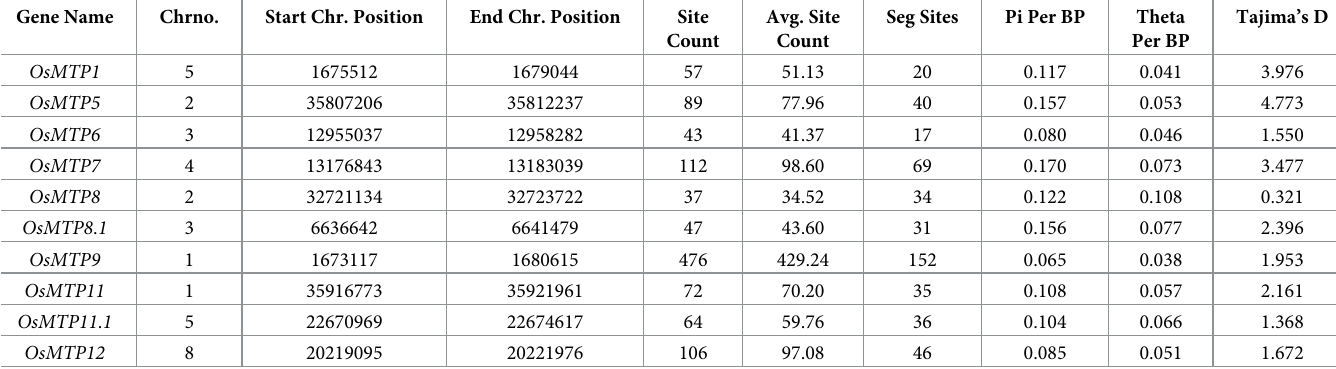
Table 3. Genetic diversity analysis of MTP genes in three thousand rice